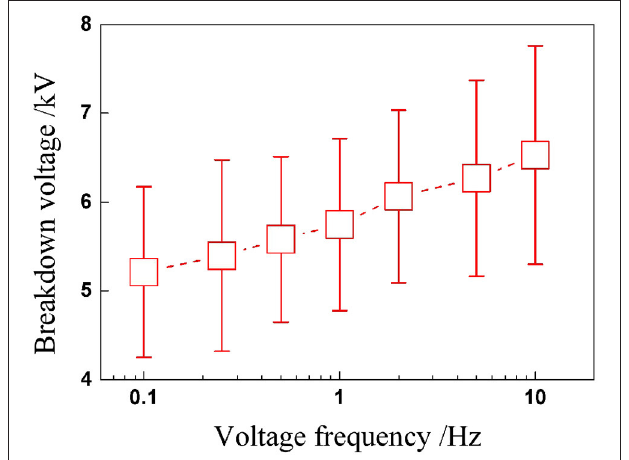
FIGURE 2 | The dynamic deformation curves of DEAs under different voltage amplitudes. FIGURE 3 | Critical voltages at breakdown under sinusoidal voltage with